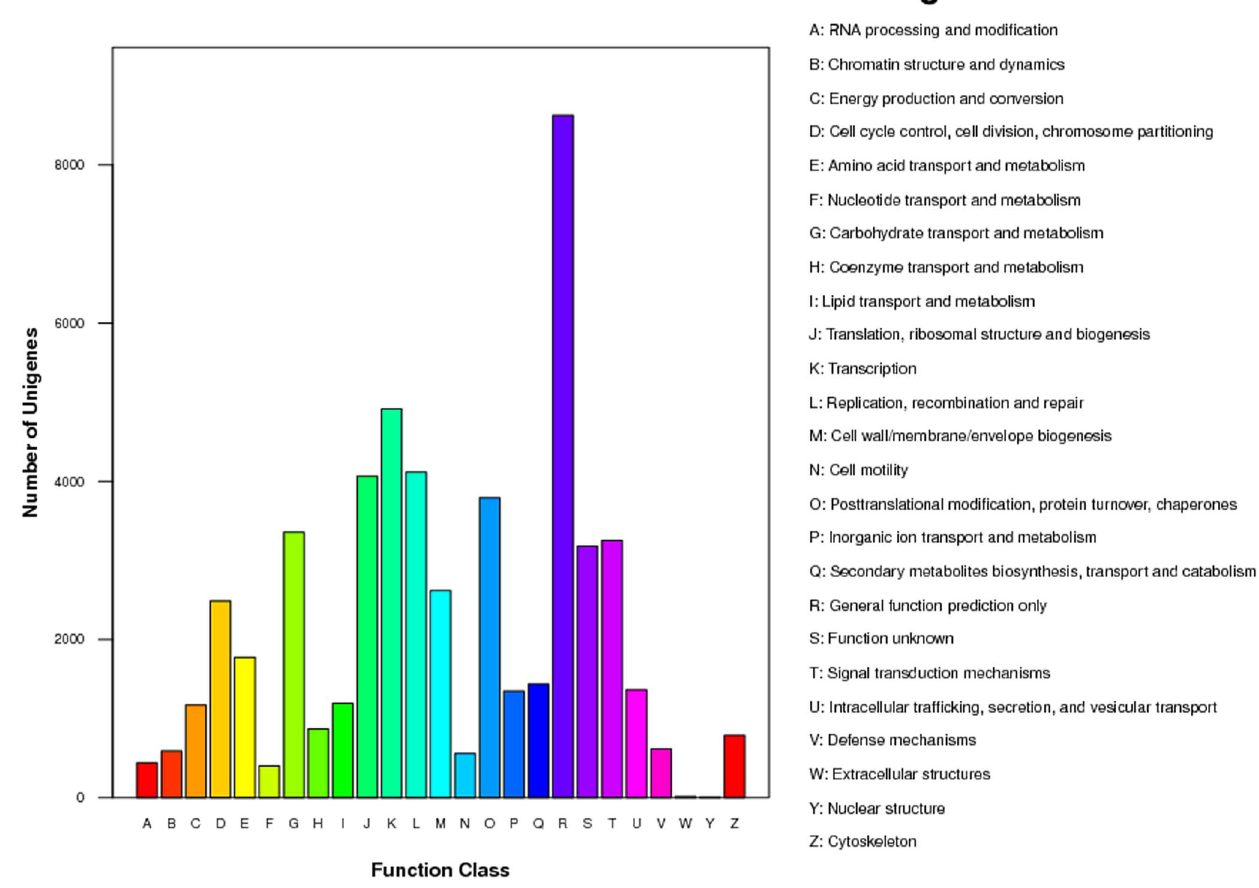
Figure 3. Clusters of orthologous groups (COG) classification. In total, 25,512 of the 60,264 sequences with Nr hits were grouped into 25 COG classifications.